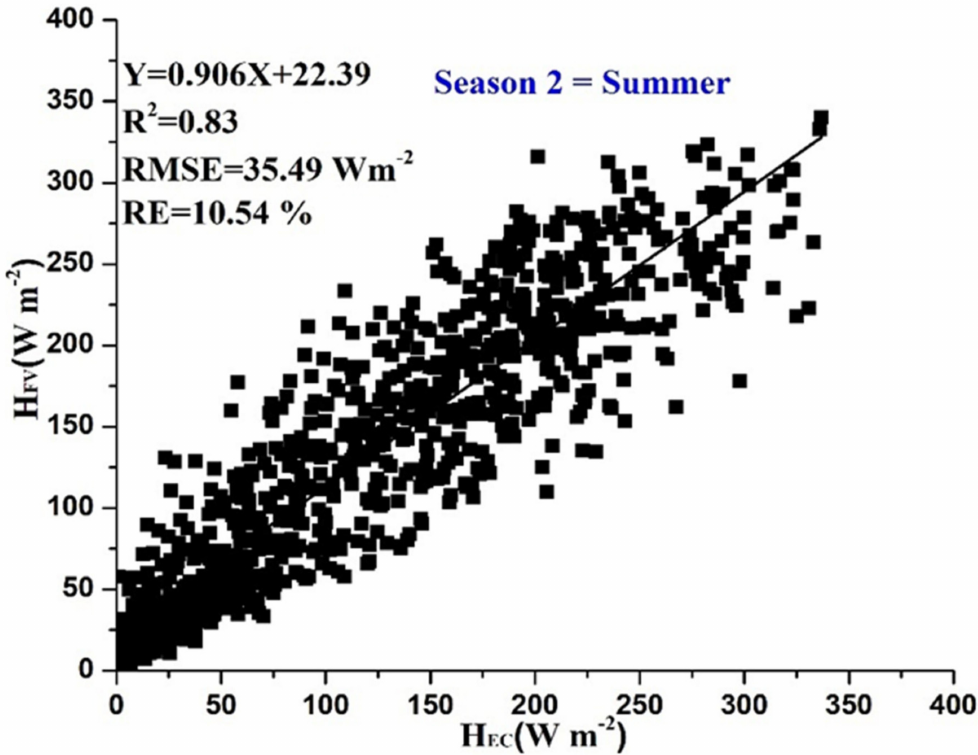
Figure 6. Regression analysis between the half-hourly dataset of H FV and H EC at the measurement height of 1.8 m for Season 2 (summer, DOY 60–210,